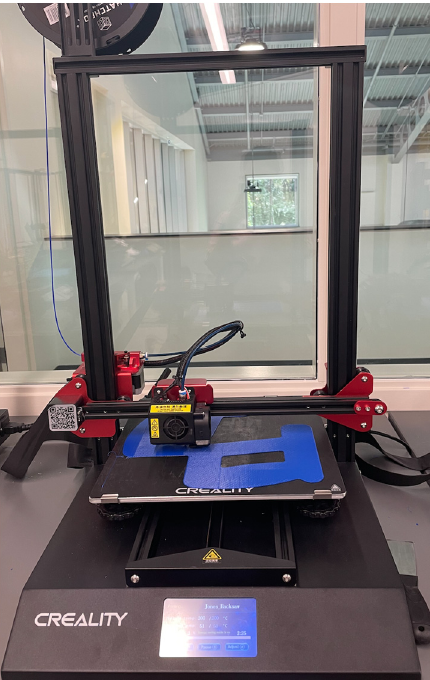
Figure 1. Example of an FDM 3D printer with a polymer filament spool